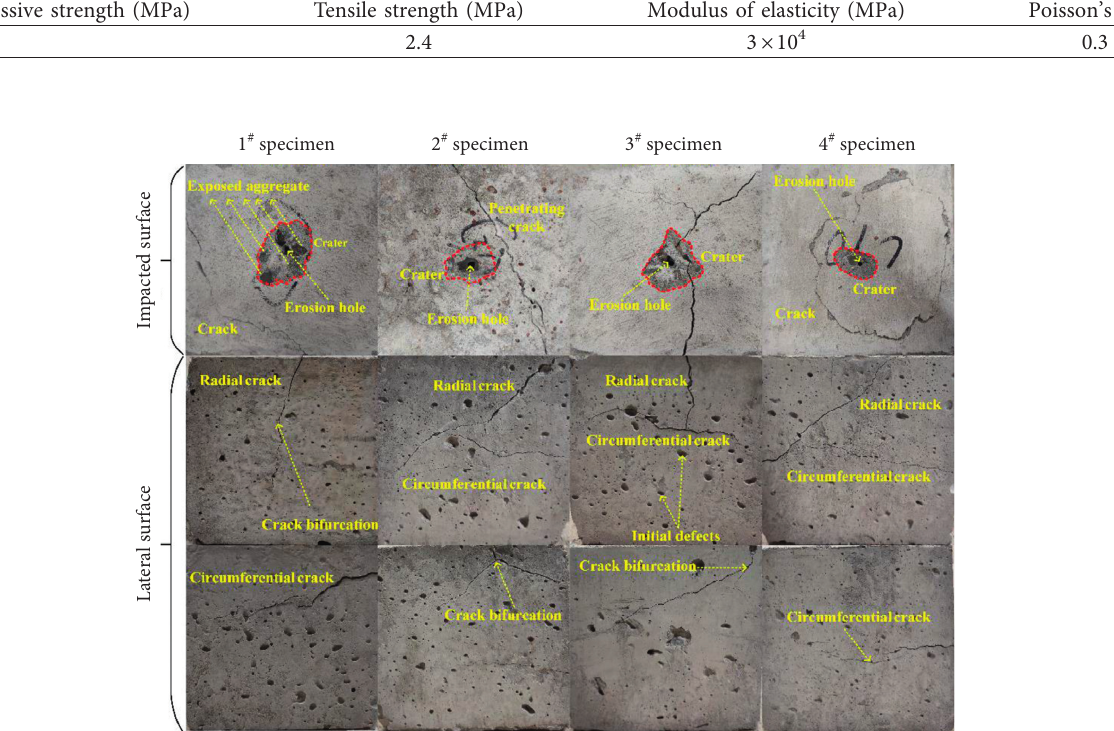
Figure 2: External morphology of concrete after AWJ impact.